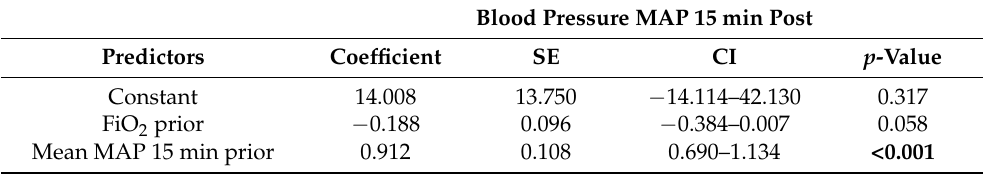
Table 3. Multiple linear regression for the MAP 15 min after the bolus application of Landiolol. Adjusted for covariates in a backward multiple regression for age, FiO 2 prior, Pinsp prior, Pmean prior, FiO 2 post, Pinsp post, Pmean post, catecholamine, rate control, regular tachycardia, enlargement of the cardiac silhouette prior, mean MAP 15 min